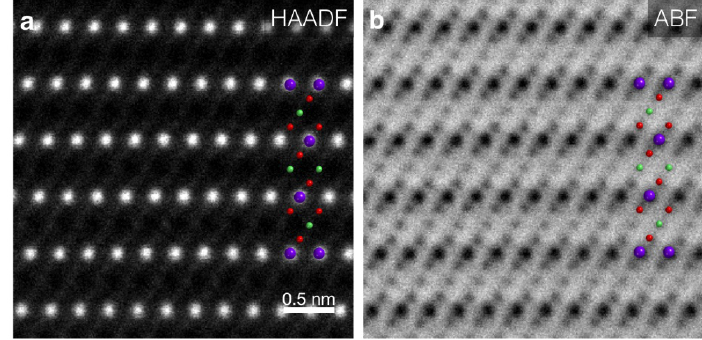
Figure 19. Simultaneously recorded ( a ) HAADF and ( b ) ABF STEM images of LiCoO2 viewed along the [100] direction. The structure models are overlaid and the colors are: Li (green), O (red), Co